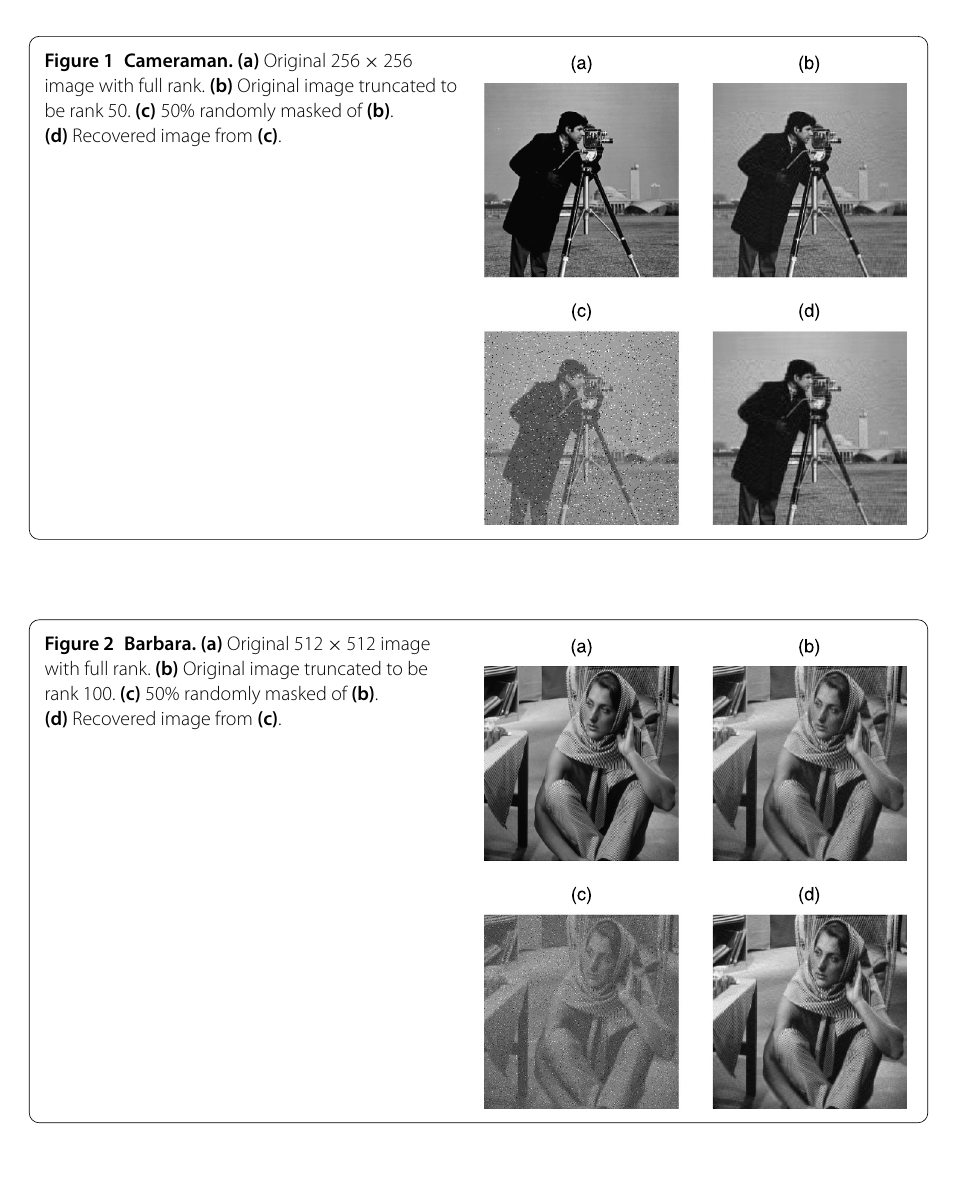
Figure 1 Cameraman. (a) Original 256 × 256 image with full rank. (b) Original image truncated to be rank 50. (c) 50% randomly masked of (b) . (d) Recovered image from (c) .